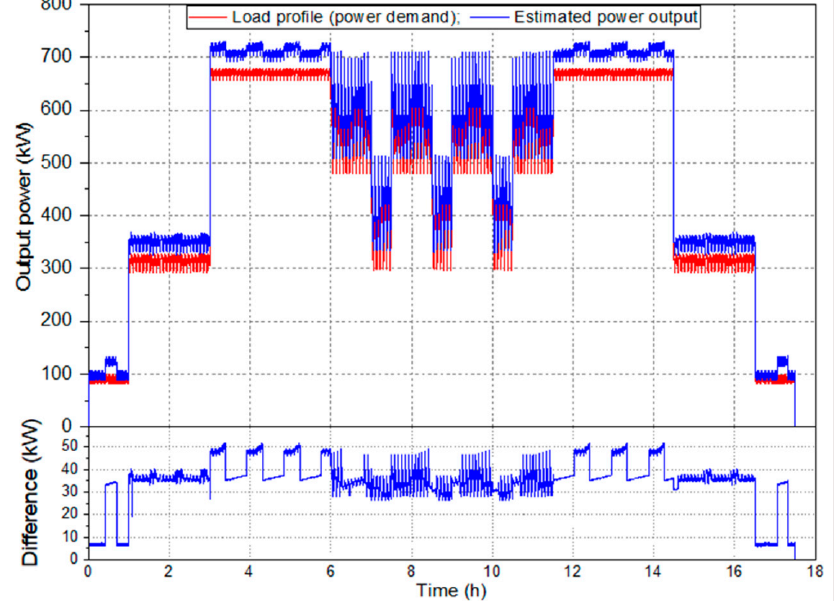
Figure 13. Load profile and estimated necessary power of the HEMV.